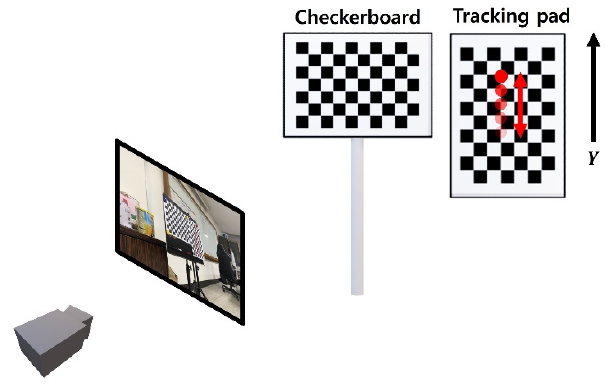
Figure 11. Configuration of the lab-scale validation test.